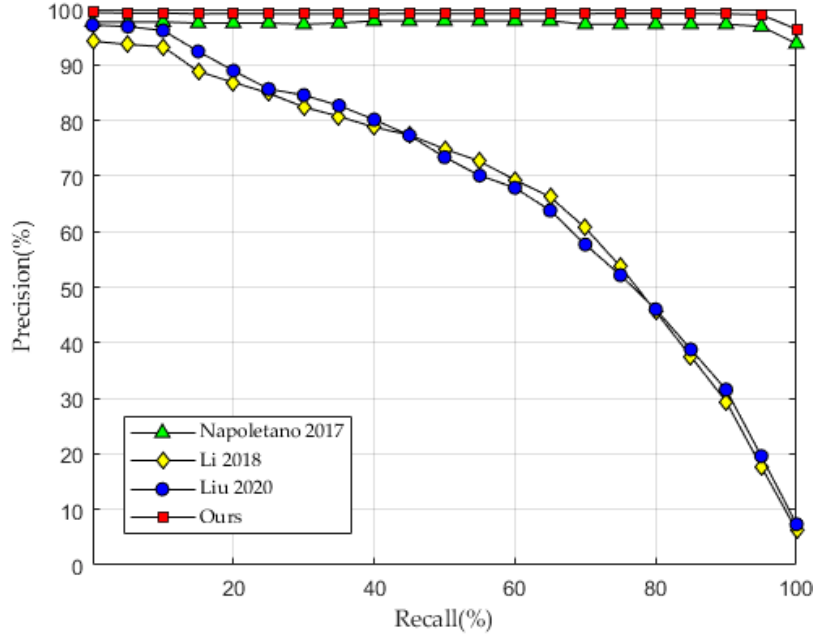
Figure 7. Comparison of PR curves between our method and other methods.